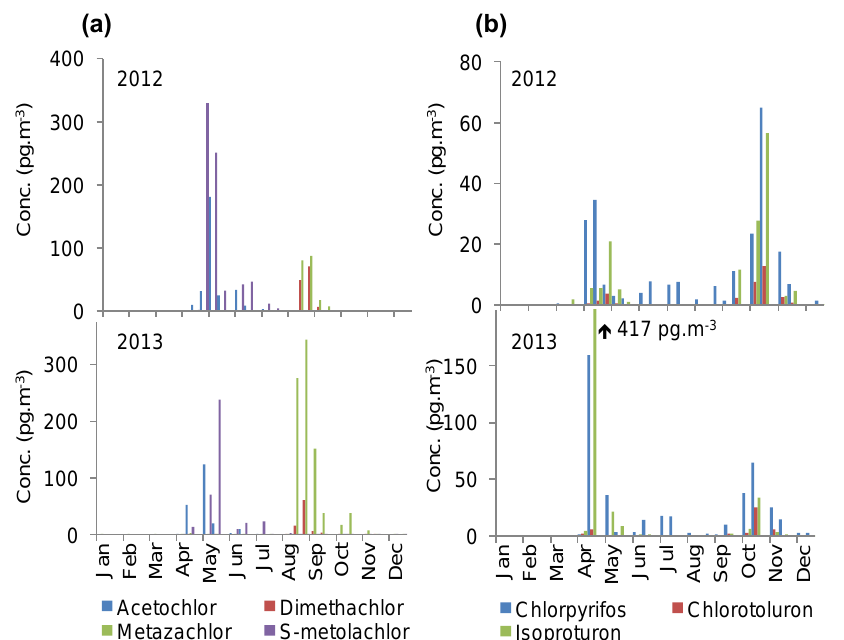
Figure 1. Seasonal variation of selected CUPs with (a) one peak per year during the growing season and (b) two peaks per year, in April–July and